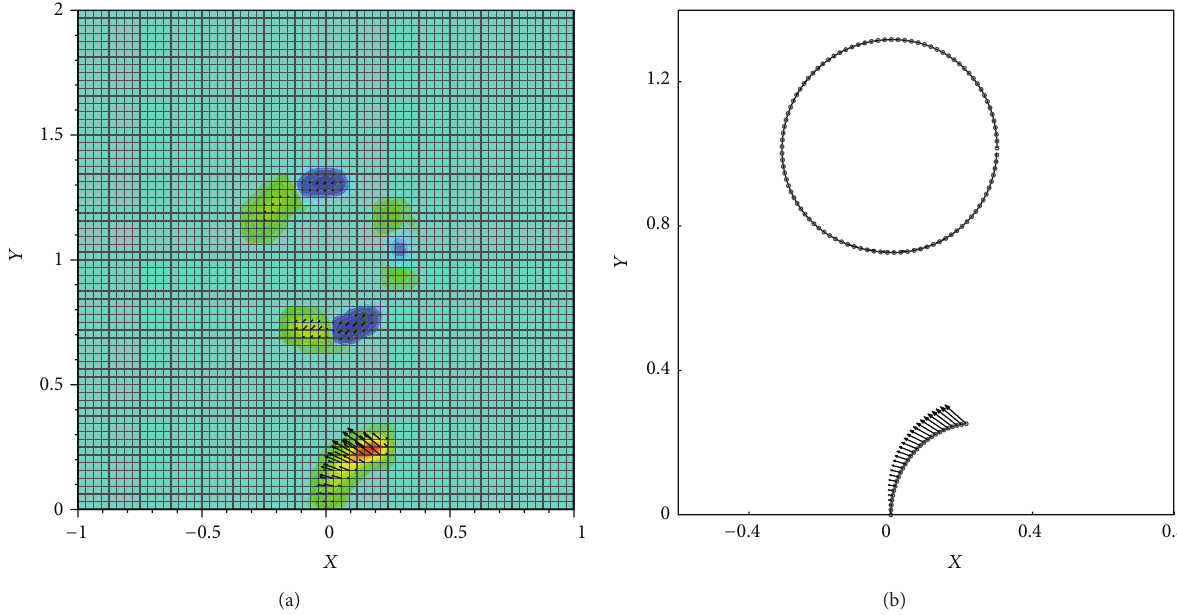
Figure 12: Eulerian forces imposed by the immersed boundaries on the fluid (a) and Lagrangian forces associated with the immersed boundaries (b) at time 𝑡 = 0.001 .